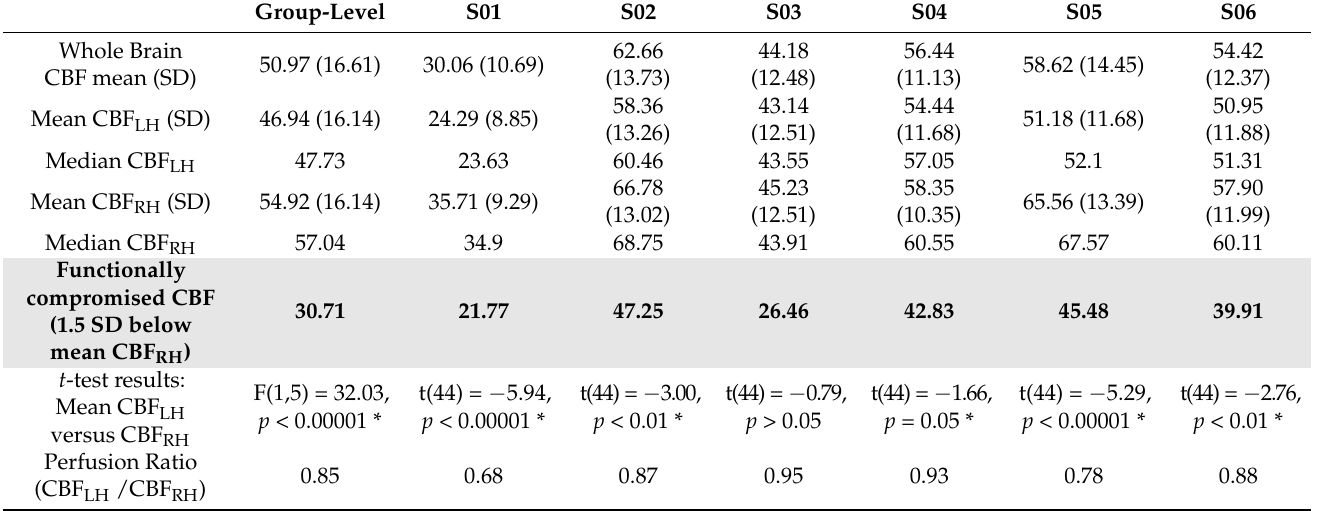
Table 3. CBF (mL/100 g tissue/min) values in gray matter for the whole brain, left (CBF LH ) and right (CBF RH ) hemispheres. Functionally compromised brain tissue (bolded) was calculated based on 1.5 standard deviations (SD) below mean CBF RH. A perfusion ratio was calculated by dividing CBF LH by CBF RH to demonstrate the extent of differences between the two hemispheres. Values < 1 indicate lower CBF LH and values > 1 indicate greater CBF LH . * Indicates a significant difference at p <